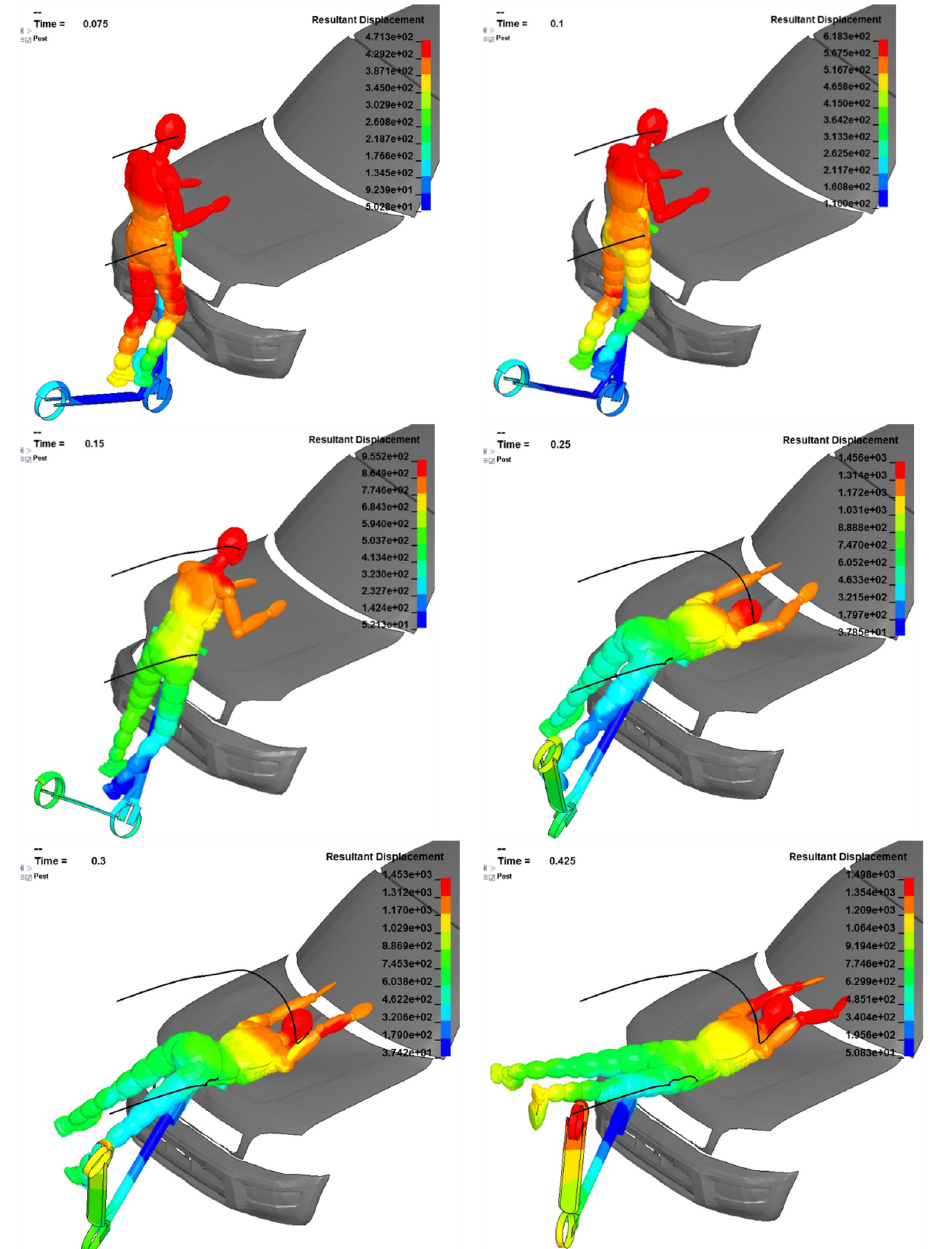
Fig 8. Dummy kinematics in the frontal scenario—The dummy’s resultant displacement in [mm], time in [s].